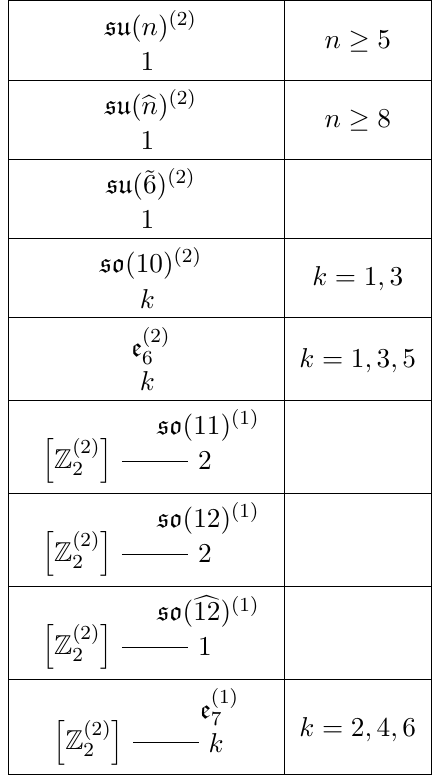
Table 1 . List of new building blocks for 5 d KK theories. See text for more